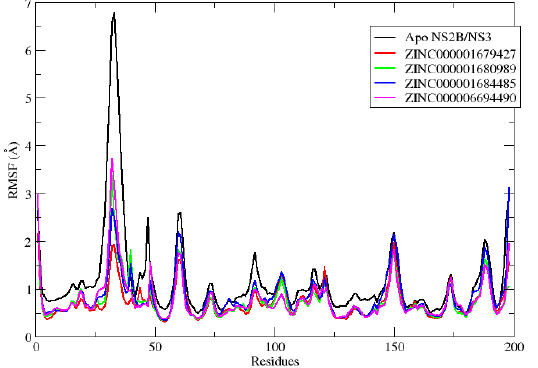
Figure 4. Graphical representation of the RMSF values versus the simulation time of the NS2B/ NS3pro Apo backbone (black line) and its complex with the ZINC000001679427 (red line), ZINC000001680989 (green line), ZINC000001684485 (blue line) and ZINC000006694490 (magenta line) complexes studied.